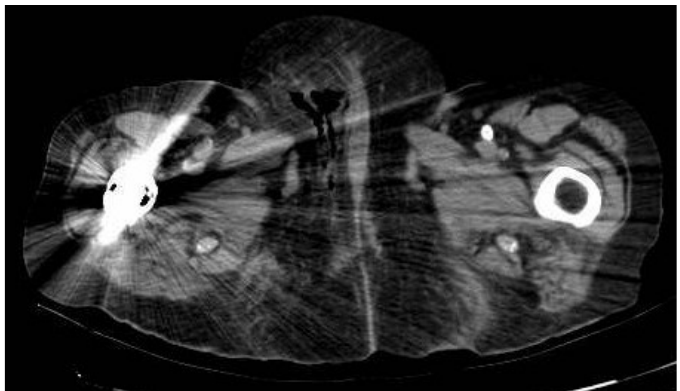
Figure 3. CT of the abdomen and pelvis showed subcutaneous edema and air inside the soft tissues of the genital area extending into the presacral soft tissues of FG. The hip replacement slightly distorts the image.